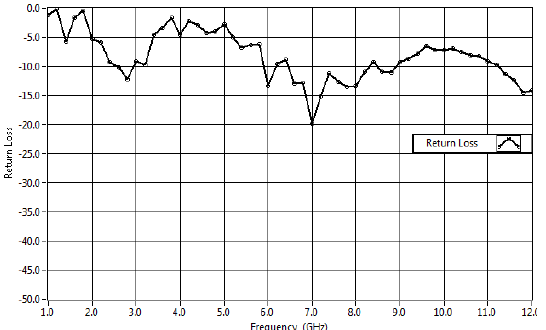
Figure 5: Return Loss, enclosure built with metallic mesh whose side is 5